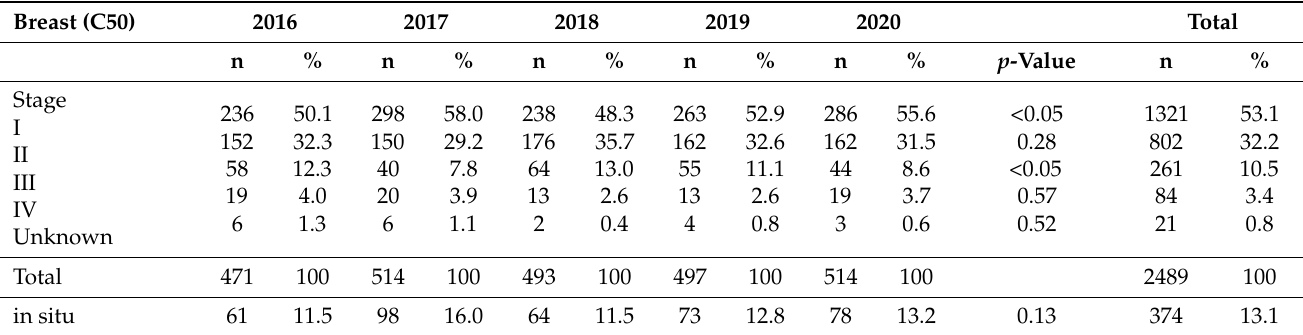
Table A1. Breast Cancer distribution by year and